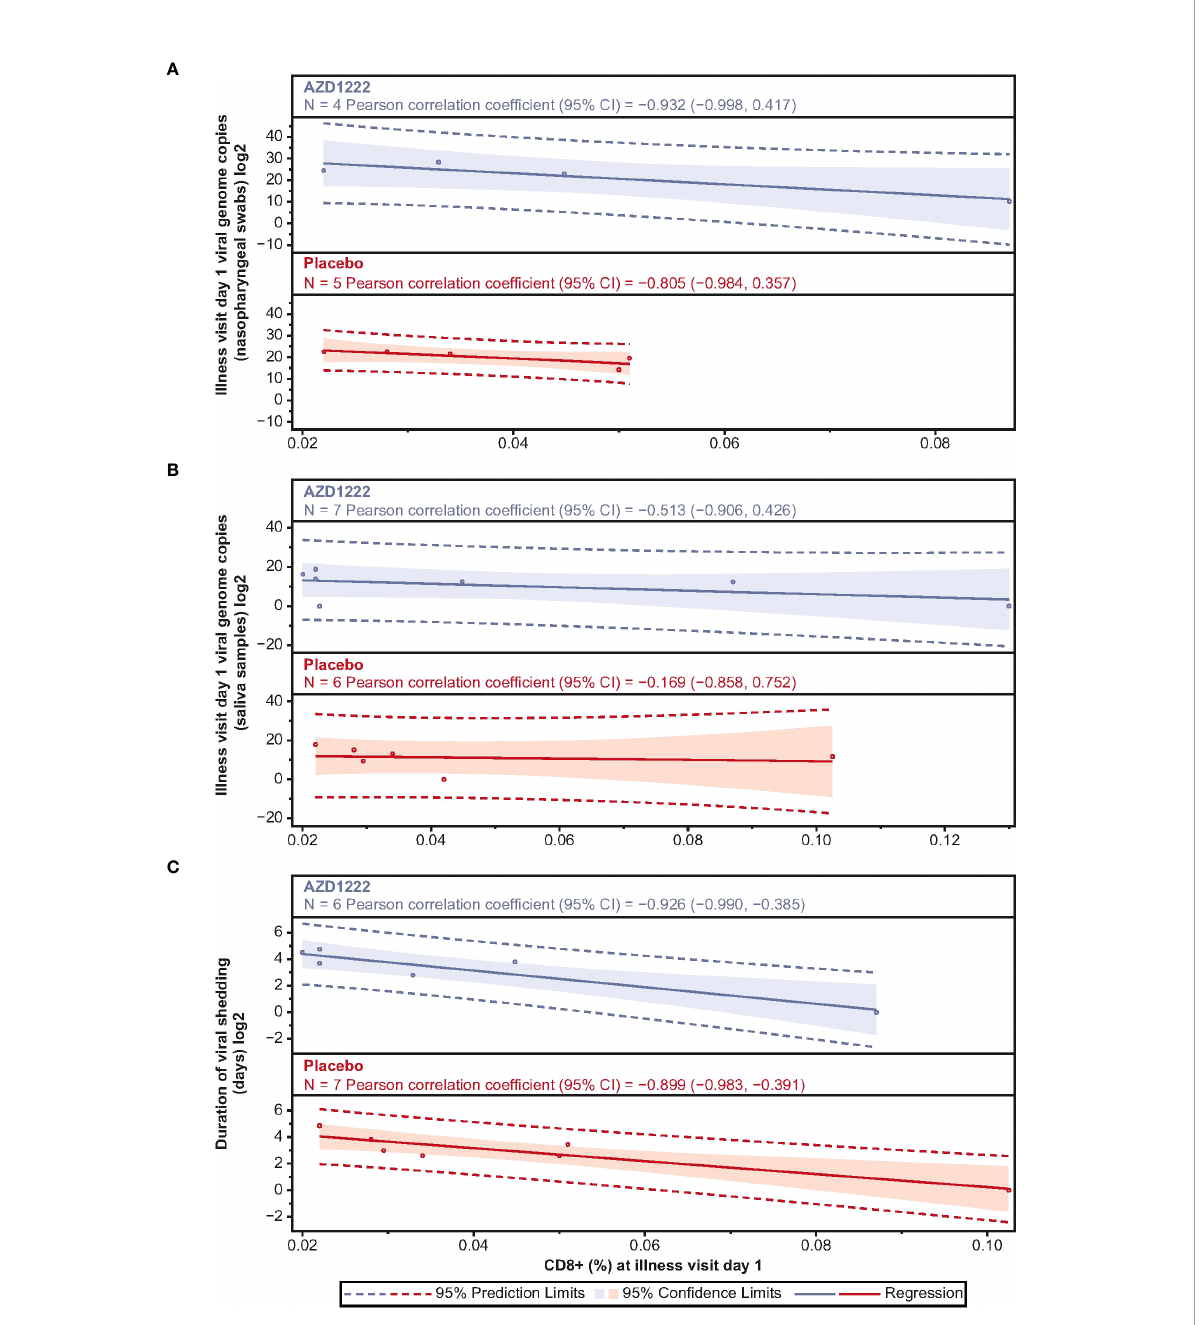
FIGURE 7 Illness visit day 1 CD8+ titers display strong negative correlations with SARS-CoV-2 virologic outcomes. Scatterplot analysis depicting the relationship between (A) SARS-CoV-2 viral load in nasopharyngeal swabs (B) SARS-CoV-2 viral load in saliva samples, and (C) duration of saliva viral shedding (y-axes) and illness visit day 1 spike-speci fi c CD8+ T cell frequencies (x-axes) in vaccinees and placebo recipients. Blue and red shading denotes 95% con fi dence limits. Dotted line denotes 95% prediction